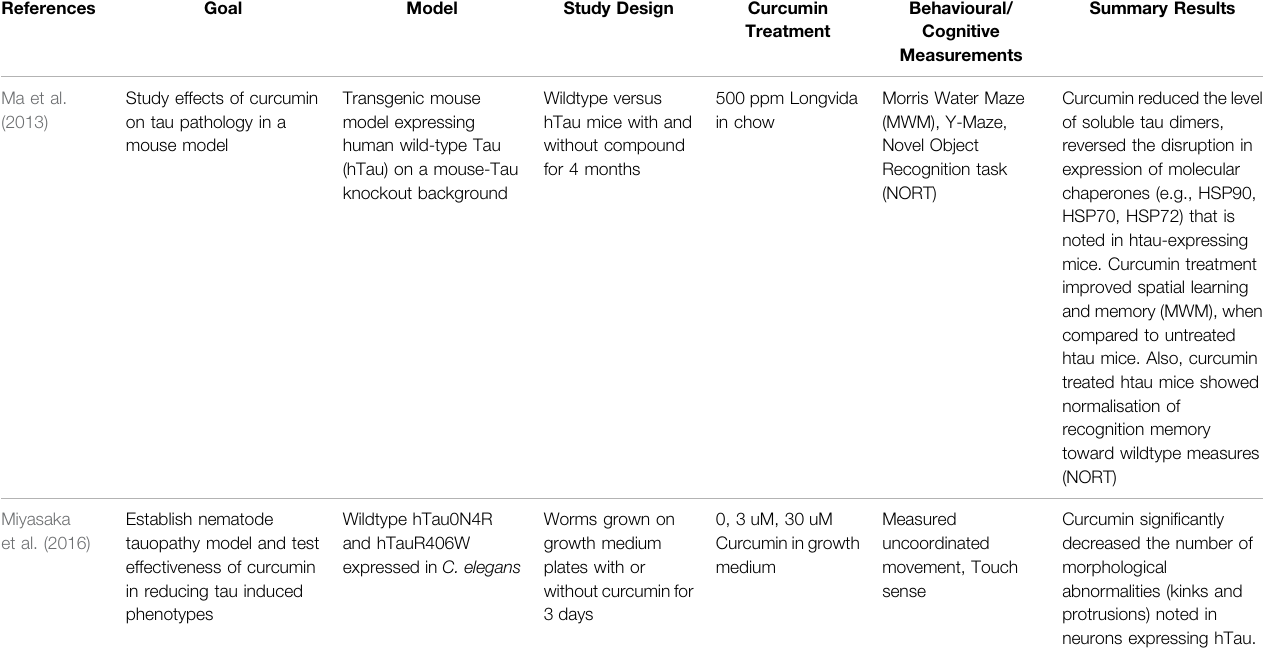
TABLE 1 | Summary of animal studies examining curcumin and tau